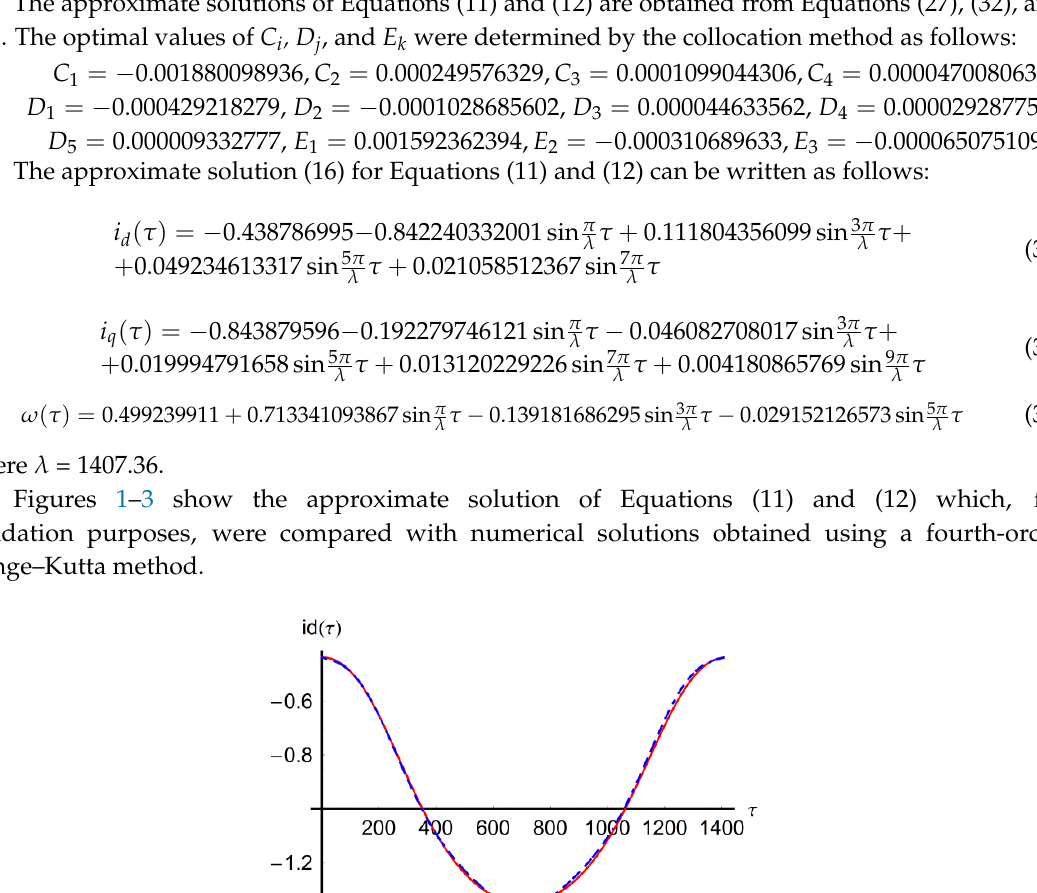
Figure 2. Comparison between the approximate solution and numerical integration results for i q : numerical, analytical solution (34) _______ numerical; _ _ _ _ _ analytical.